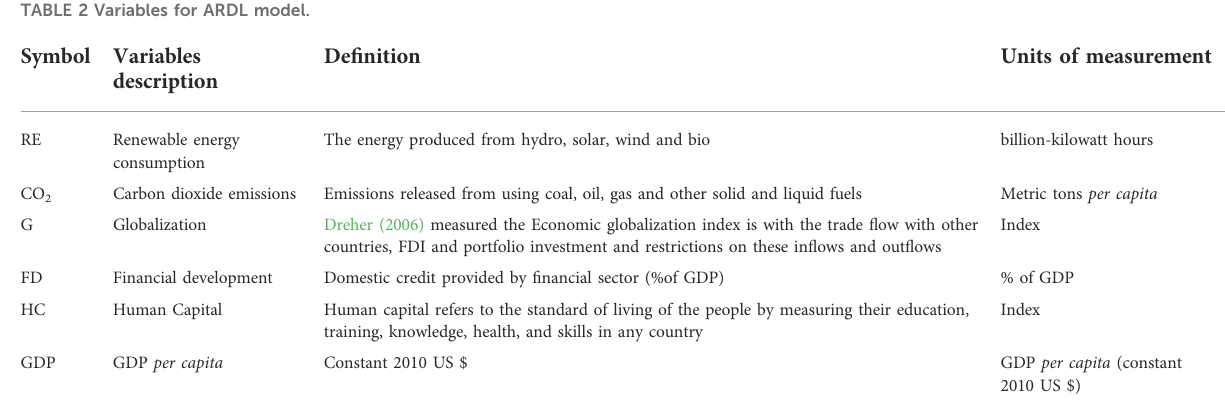
TABLE 2 Variables for ARDL model.